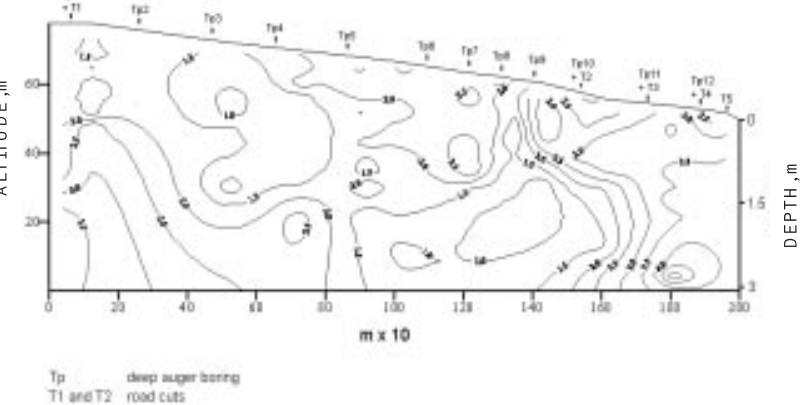
Figure 7. Isolines showing the variation of the fine sand/coarse sand relation on the summit and shoulder segments.